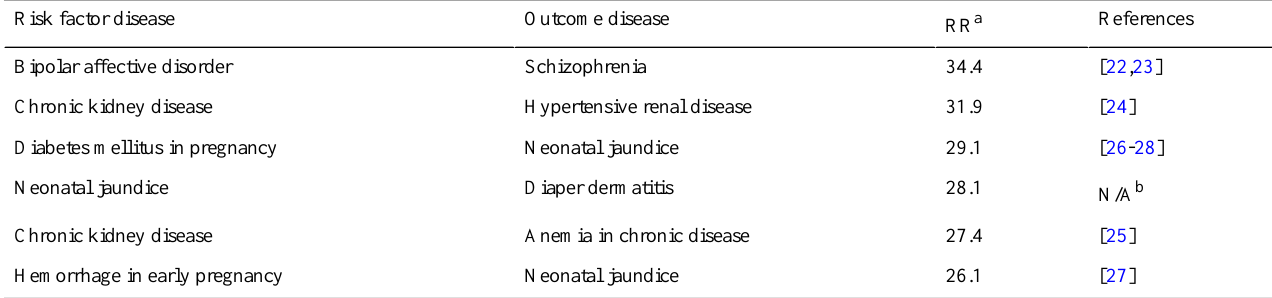
Table 2. Top relative risk values.